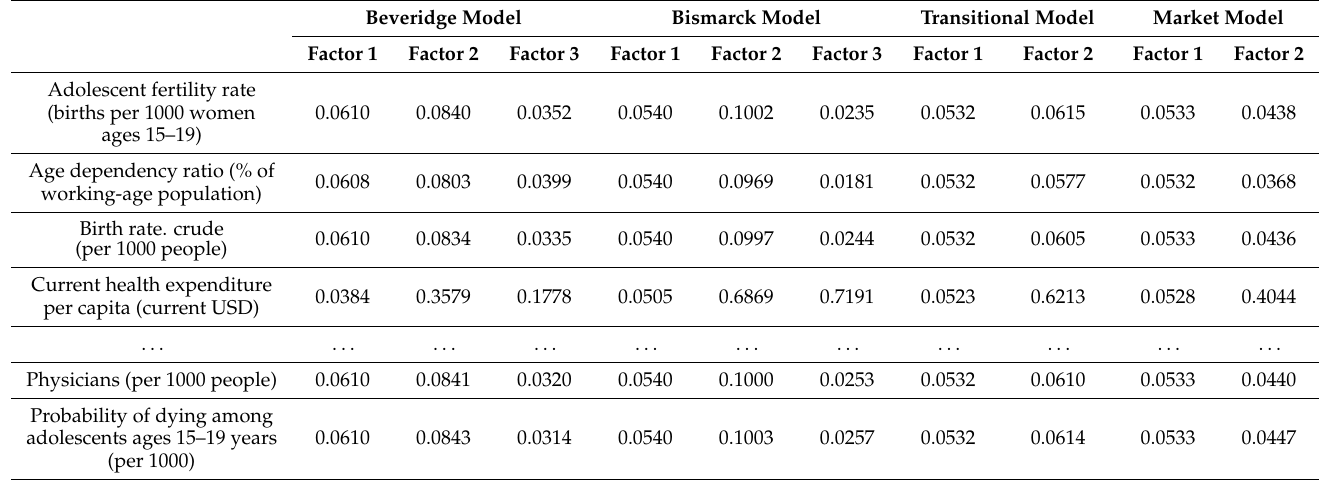
Table 1. Case contributions, based on correlations in the section of each factor (fragment). Beveridge Model Bismarck Model Transitional Model Market Model Factor 1 Factor